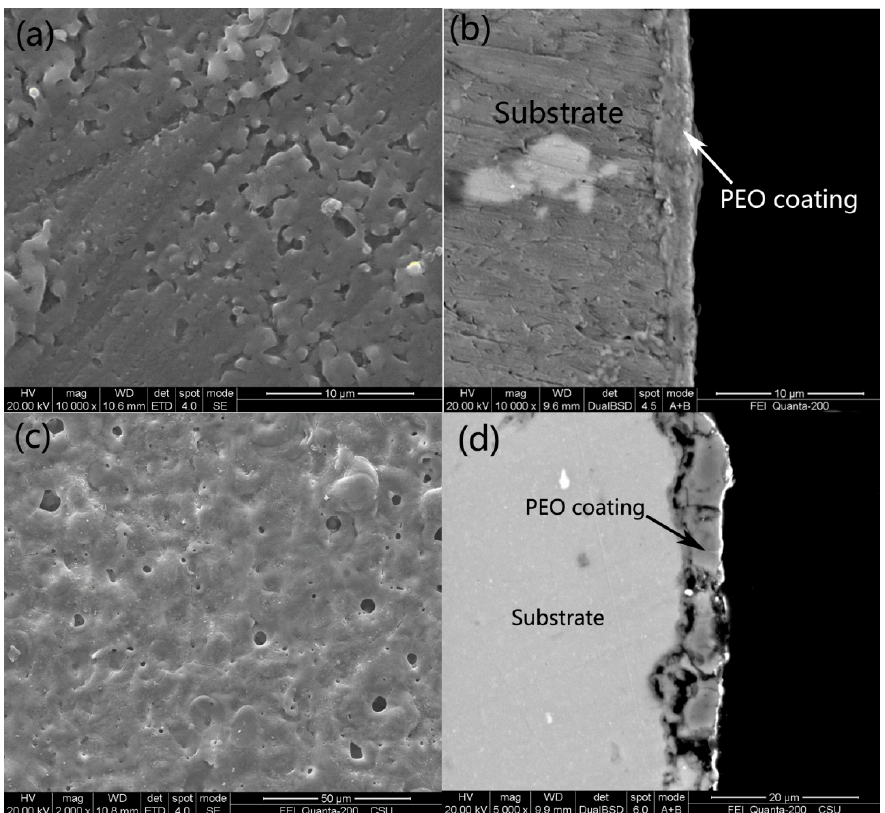
Figure 2. SEM morphology of PEO coating: Surface morphology ( a ) at 4 min PEO time; ( c ) at 15 min PEO time; cross section morphology ( b ) at 4 min PEO time; ( d ) at 15 min PEO time. The surface of the PEO samples with a silane coating (outer) and a PEO coating (in-